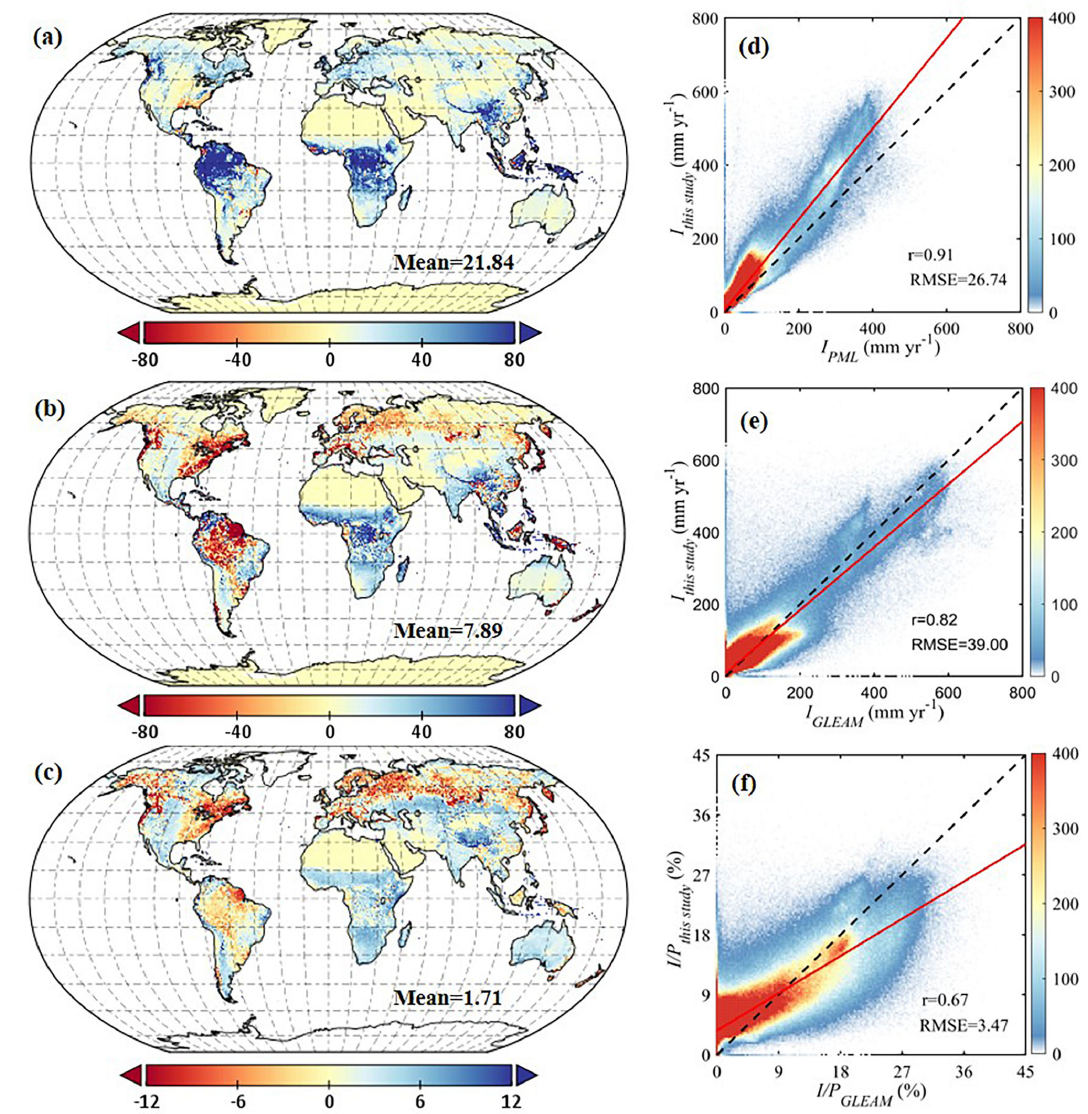
Figure 8. Comparison of rainfall interception with other global products. The left column is the spatial distribution of their differences, i.e. this study minus (a) PML I (mmyr − 1 ), (b) GLEAM I (mmyr − 1 ) and (c) GLEAM I/P (%). The right column is the pixel-by-pixel scatter plot of this study versus (d) PML I (mmyr − 1 ), (e) GLEAM I (mmyr − 1 ) and (f) GLEAM I/P (%), in which the solid red line represents the fitting curve, the dashed black line marks the 1-to-1 line and the colour bar represents data